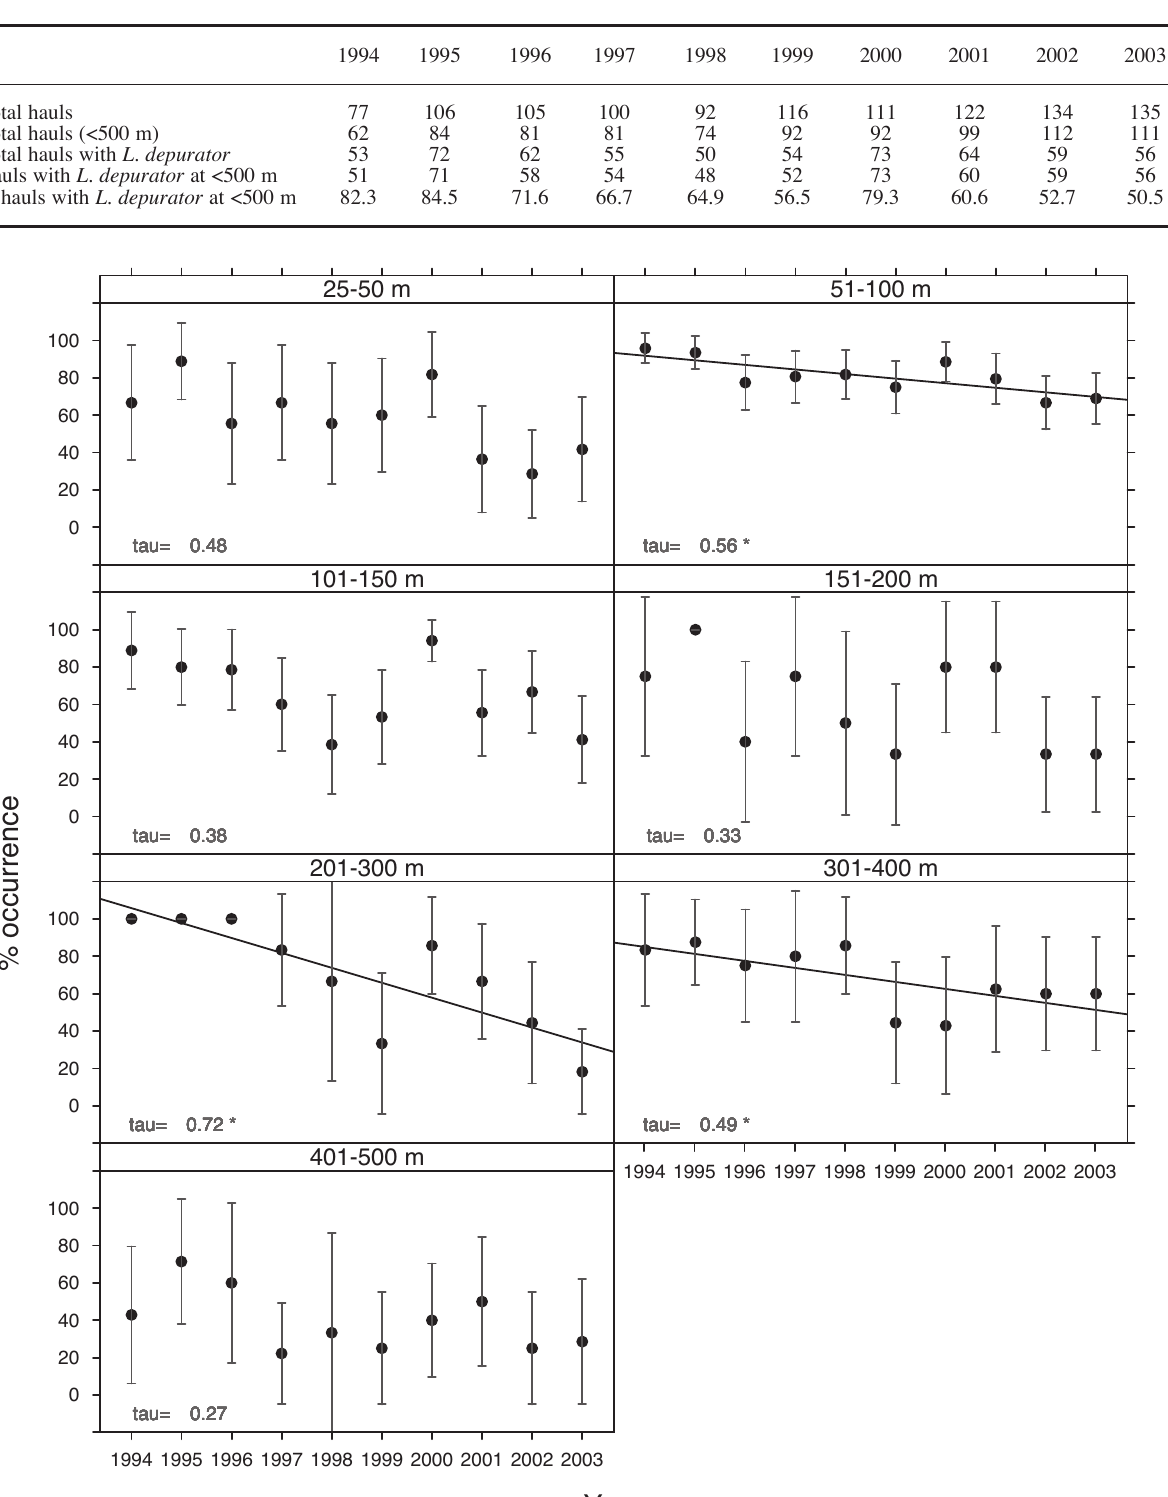
F IG . 4. – Annual variation of the percentage occurrence (± CI ) of Liocarcinus depurator grouped into depth intervals. The value of 95% Kendal’s T is indicated in the bottom left corner of each figure, followed by an * when significant. Lines fitted to significant relationships by least squares regression are merely indicative of the